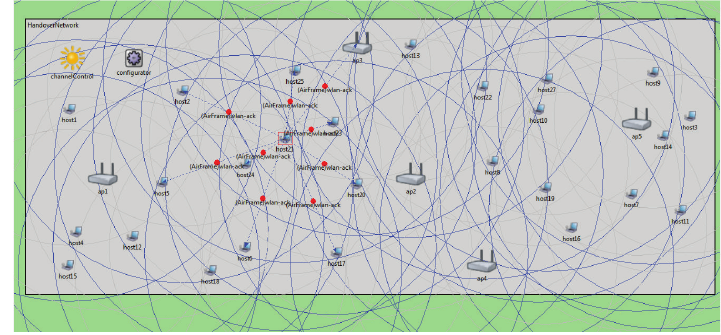
Figure 9: Simulation